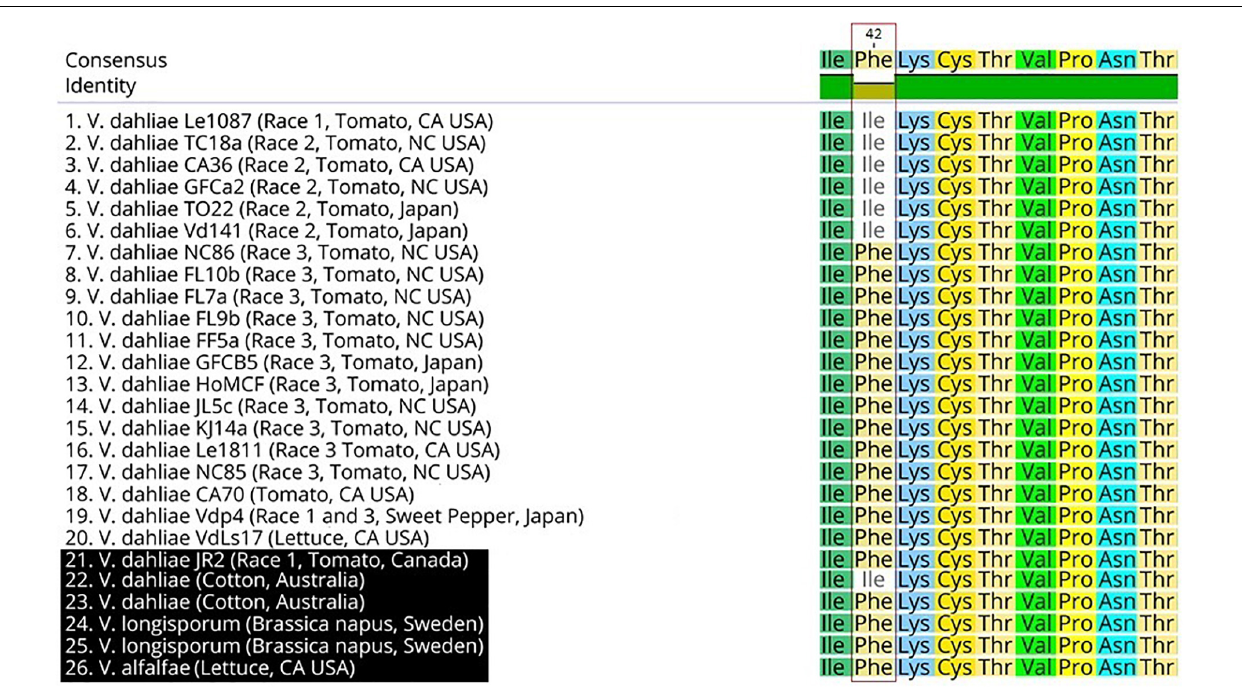
FIGURE 6 | Protein sequence alignment of the R2C1 VdPDA1 gene. Sequences highlighted in black (21–26) have not been tested for the race2/3 phenotype. A single nucleotide polymorphism of A to T results in an isoleucine (ATC) to phenylalanine (TTC)